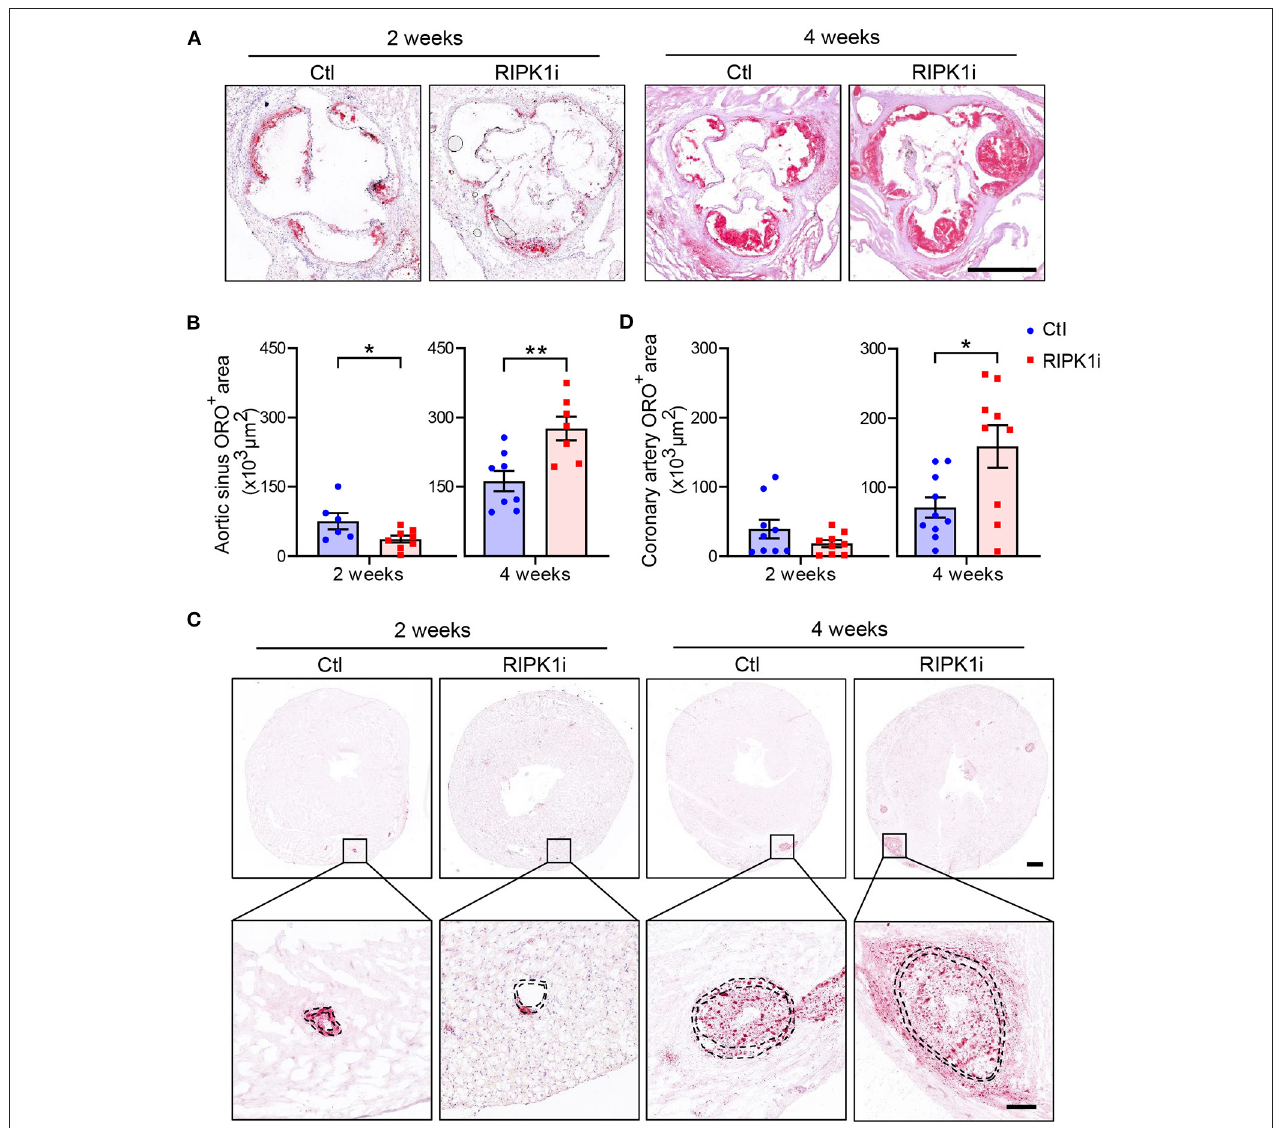
FIGURE 2 | Differential impacts of RIPK1 inhibition on early and late atherogenesis in mice. Male ApoE SA / SA mice were fed a western diet contained RIPK1 inhibitor GSK547 (RIPK1i, 10 mg/kg) or not (Ctl) for 2 or 4 weeks with Dox-containing water to induce hypertension. Representative histological analysis of cross-sections from the aortic sinus stained with Oil Red O (A) and quantification of aortic sinus Oil Red O-positive area of male mice (B) . Scale bar = 500 µ m. Representative histological analysis of heart cross-sections stained with Oil Red O (C) and quantification of coronary artery (D) Oil Red O-positive area of male mice. Panel C , scale bar = 500 µ m, top; scale bar = 100 µ m, bottom. Dashed lines showed vessel media. Blue symbols = Ctl group, pink symbols = RIPK1i group. n = 6–10 mice per group. All the data represented as mean ± SEM; * P < 0.05, ** P < 0.01. Statistical analysis: unpaired student’s t test.